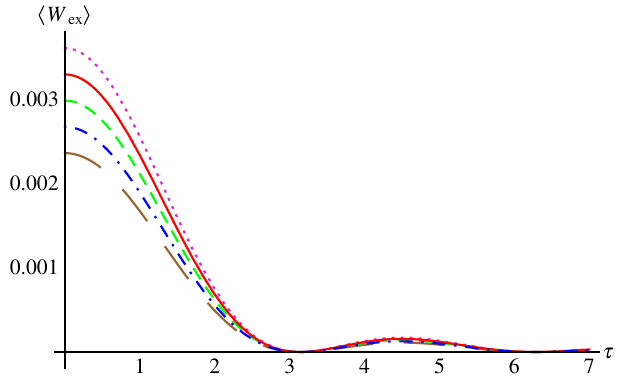
FIG. 14. Excess work under linear driving as a function of the driving time for two statistical anyons with p B = 1 (long dashed, brown), p B = 0 (dotted, dark pink), p B = 1 / 2 (dashed, green), p B = 3 / 4 (dot dashed, blue), and p B = 1 / 4 (solid, red) using a linear protocol. Parameters are ω 0 = β = (cid:2) = 1, and δω =